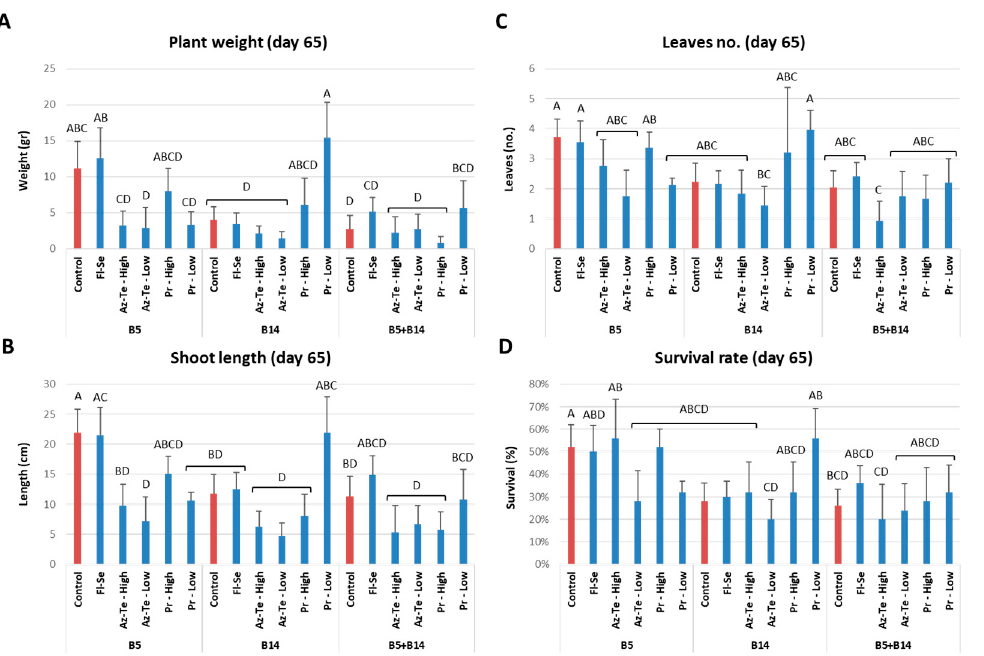
Figure 5. Effect of pesticide treatments on the growth indexes and survival of red onion plants (Noam cv.) 65 days after soil surface germination. The experiment and abbreviations are described in Figure 2. The mid-season evaluation included the plants’ weight ( A ), shoot length ( B ) and phenological development (number of leaves, C ). Each value is an average of four plants/pot. The survival rate ( D ) is the percentage of five plants/pot. B5- F. acutatum , B14- F. oxysporum f. sp. cepae . Bars indicate the mean of five (Prochloraz and Az-Te) or 10 (Fl-Se) biological replications (pots). Controls (red columns) are plants without fungicides. Error bars are standard errors. Different letters above the chart's bars (A–D) represent a significant difference ( p < 0.05) in the ANOVA test.